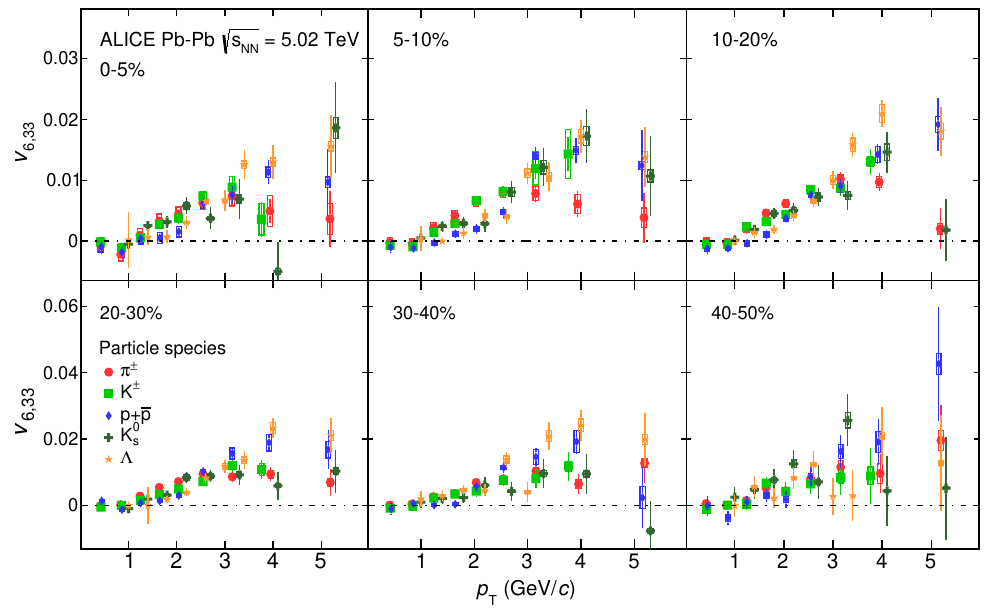
Figure 8 . The p T -di(cid:11)erential v 6 ; 33 for di(cid:11)erent particle species grouped into di(cid:11)erent centrality p intervals of Pb-Pb collisions at s NN = 5 : 02 TeV. Statistical and systematic uncertainties are shown as bars and boxes,